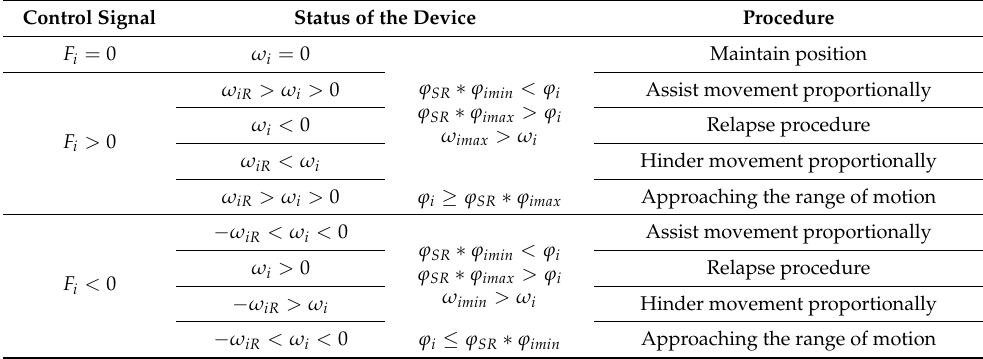
Table 1. Simplified principle of the prediction